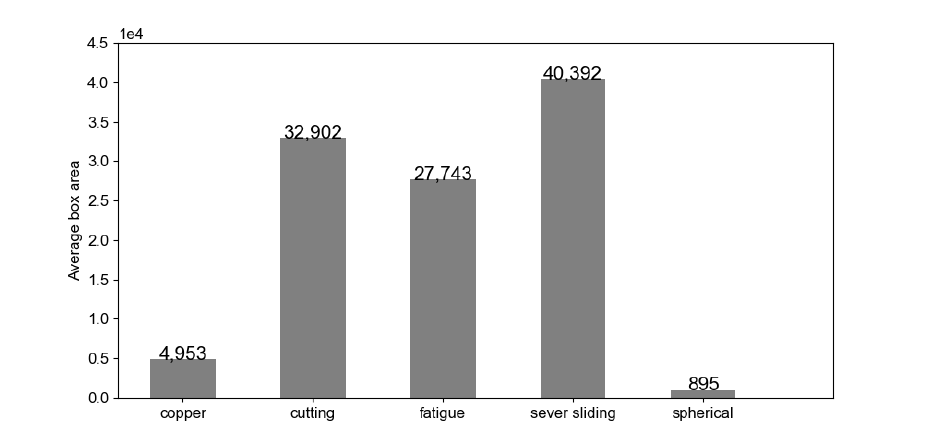
Figure 9. Average bounding box size by defect